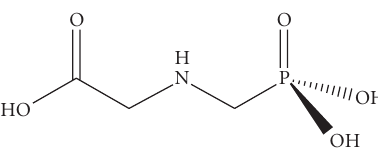
Figure 1: Chemical structure of